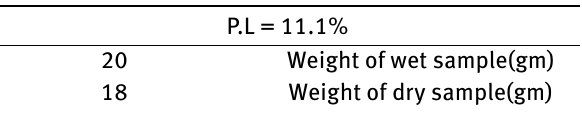
Table 4: Results of the compaction test of the untreated gypseous